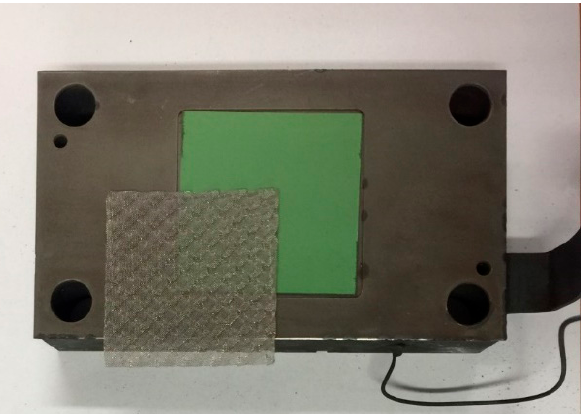
Figure 2. Commercial-sized SOFC: setup with a metal housing and a Ni current collector mesh. The housing is placed in an electric furnace equipped with a temperature control system. Feeding gas lines are supplied with technical-purity hydrogen and nitrogen, compressed atmospheric air and deionised water. Gas flow rates are controlled by digital mass flow meters, while water steam is regulated with a temperature-controlled bubbler. Reversible operation is managed by an electronic system made of a controller (Arduino) plus an electronic load. Online electrochemical impedance (EIS) measurements are accomplished with a potentiostat (Biologic SP-240, ranges: current 4 A, voltage 2 V). A descriptive scheme of the test rig and related instruments is provided in Figure 3. Figure 3. SOFC test rig scheme: mechanical and electrical connection, measurement hardware. 2.2. Methods EIS is periodically acquired during each test to have a complete overview of performance evolution. The EIS scans are performed in galvanostatic mode with a 350- mA-amplitude current wave. The EIS scan begins at 100 kHz and ends at 100 mHz (12